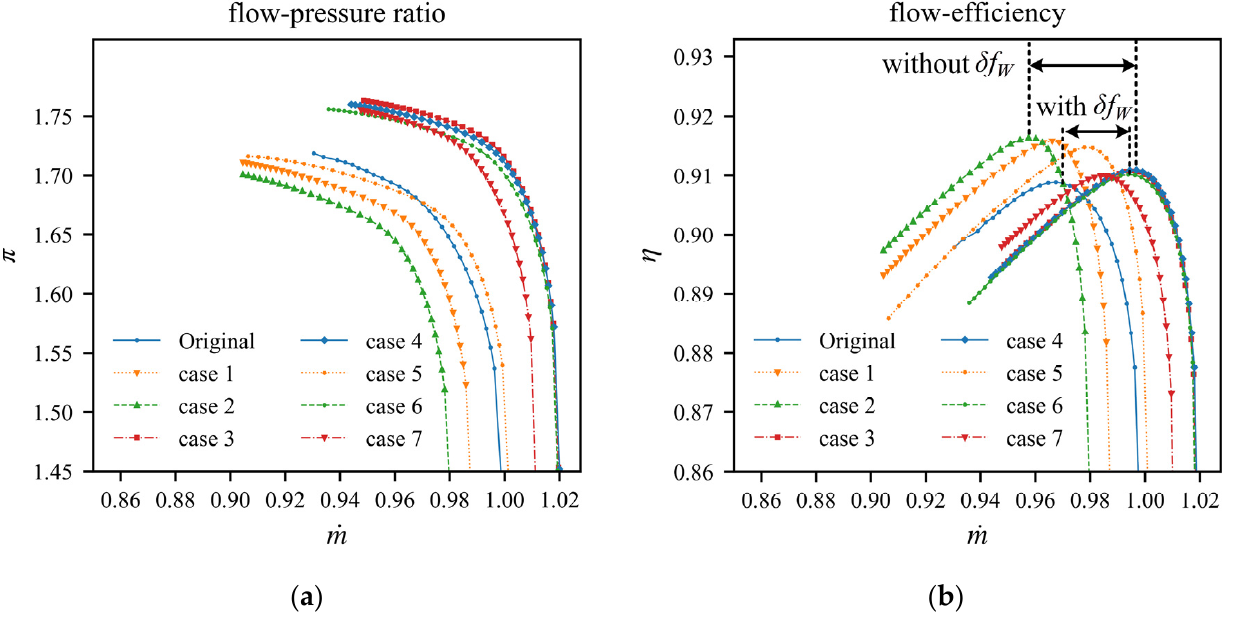
Figure 12. Operating characteristics of selected individuals. ( a ) Flow-pressure ratio. ( b ) Flow efficiency.